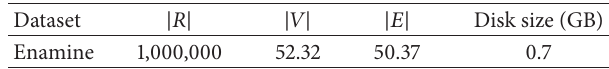
Table 3: Dataset